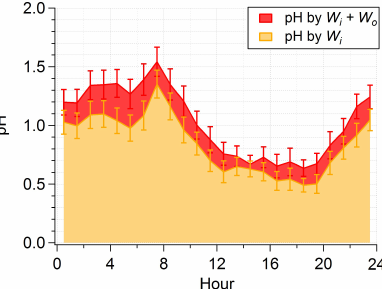
Figure 13. CTR (SOAS) pH diurnal profiles based on total pre- dicted water and W i , respectively. Median hourly averages and stan- dard error bars at local hour are